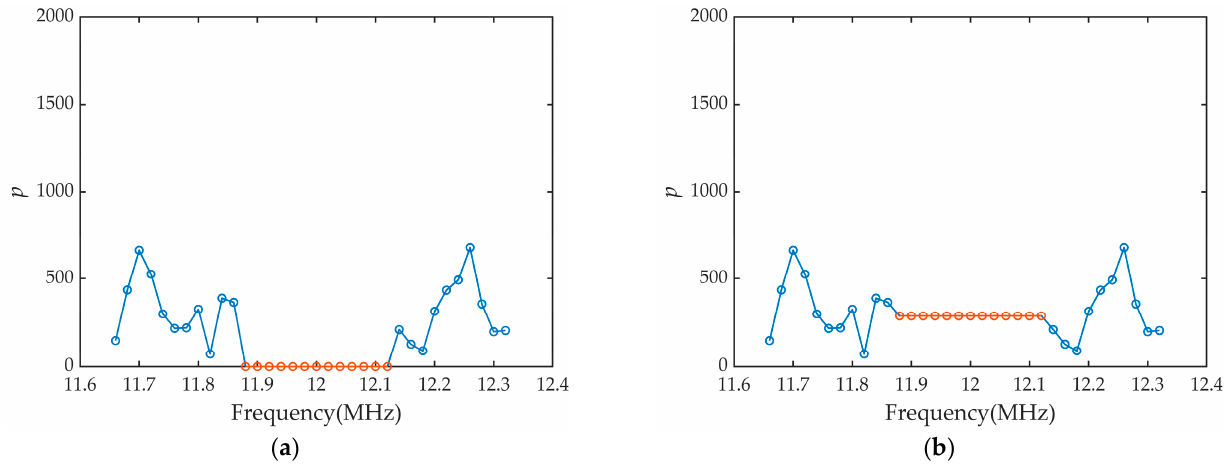
Figure 5. Partial enlargement of the spectrum using different p processing methods. ( a ) Partial enlargement of the spectrum at 12 MHz after using the zero-setting method for the parameter α = 6. ( b ) Partial enlargement of the spectrum at 12 MHz after using the averaging method for the parameter 6 α= .